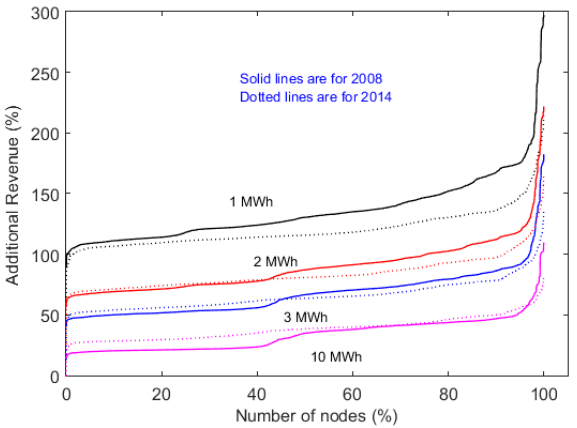
Figure 20. Additional revenue in energy arbitrage in RTM relative to day-ahead market (DAM) in 2008 and 2014 for different energy capacities with 1 MW power capacity.